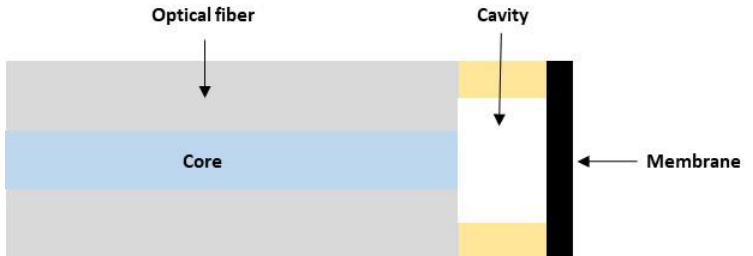
Figure 2. Topology of Fabry – Perot cavity sensor with a membrane as a mechanical transducer.